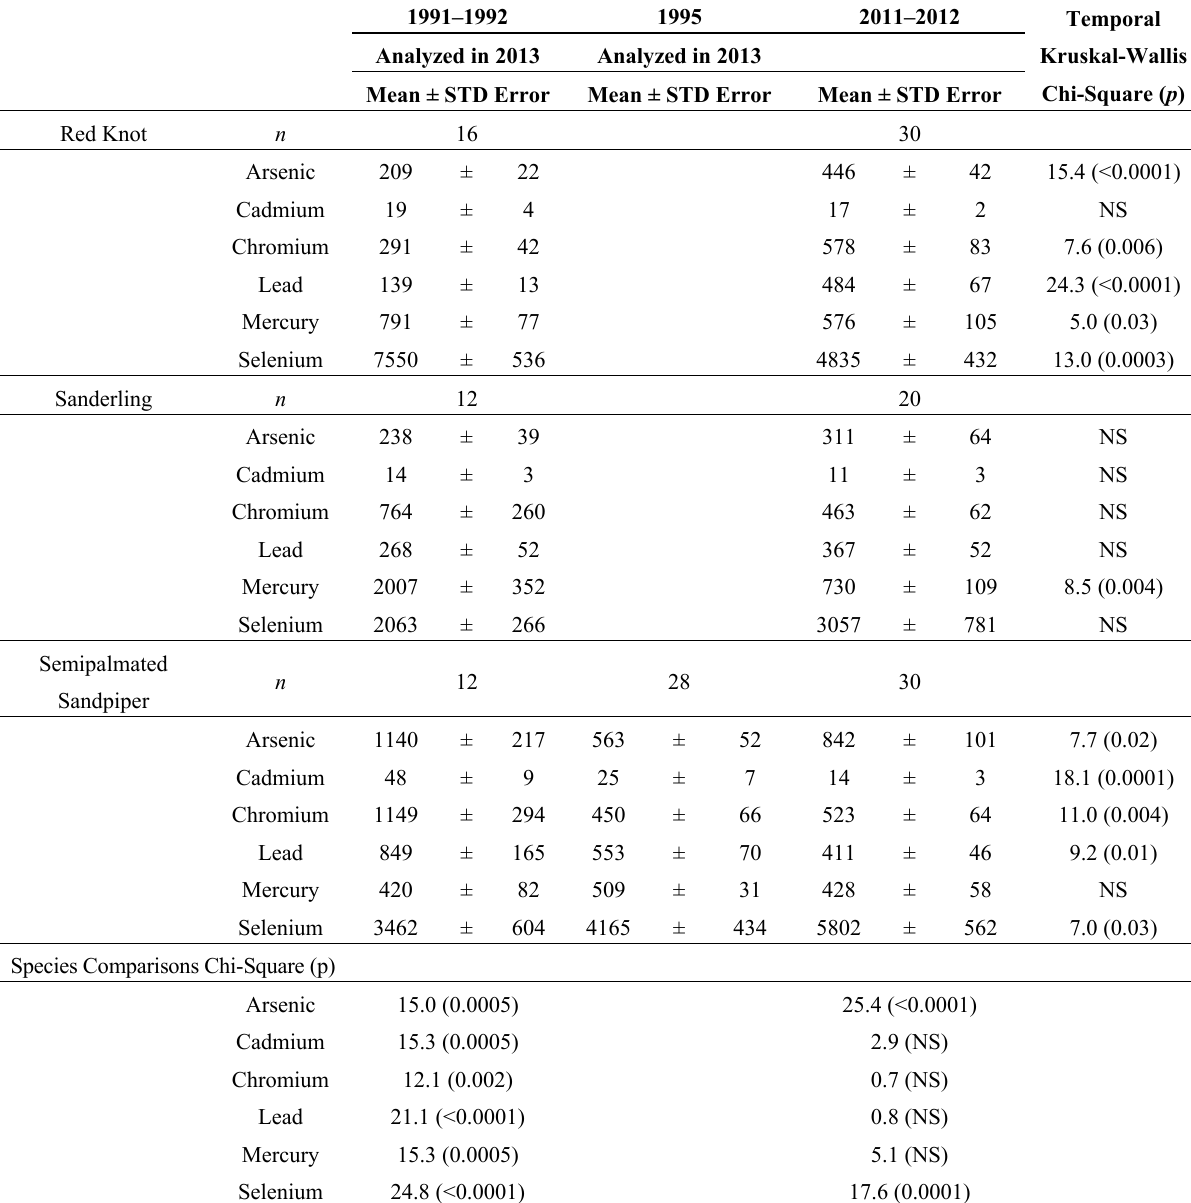
Table 1. Temporal patterns in element levels (ng·g −1 , dry weight) in feathers of Red Knot, Sanderling, and Semipalmated Sandpipers from Delaware Bay, NJ,